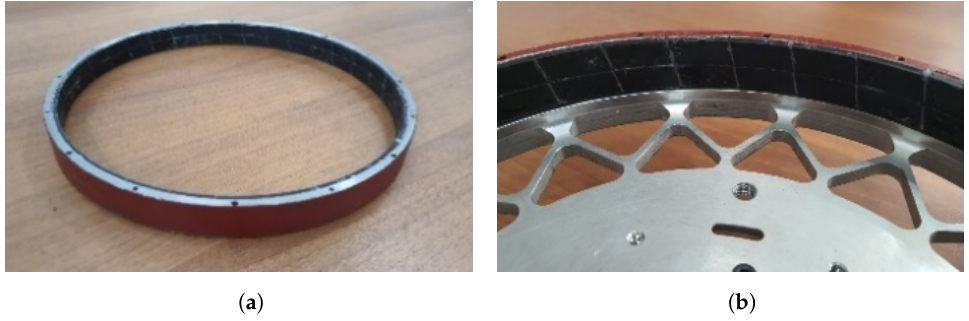
Figure 22. ( a ) Rotor structure. ( b ) Magnet